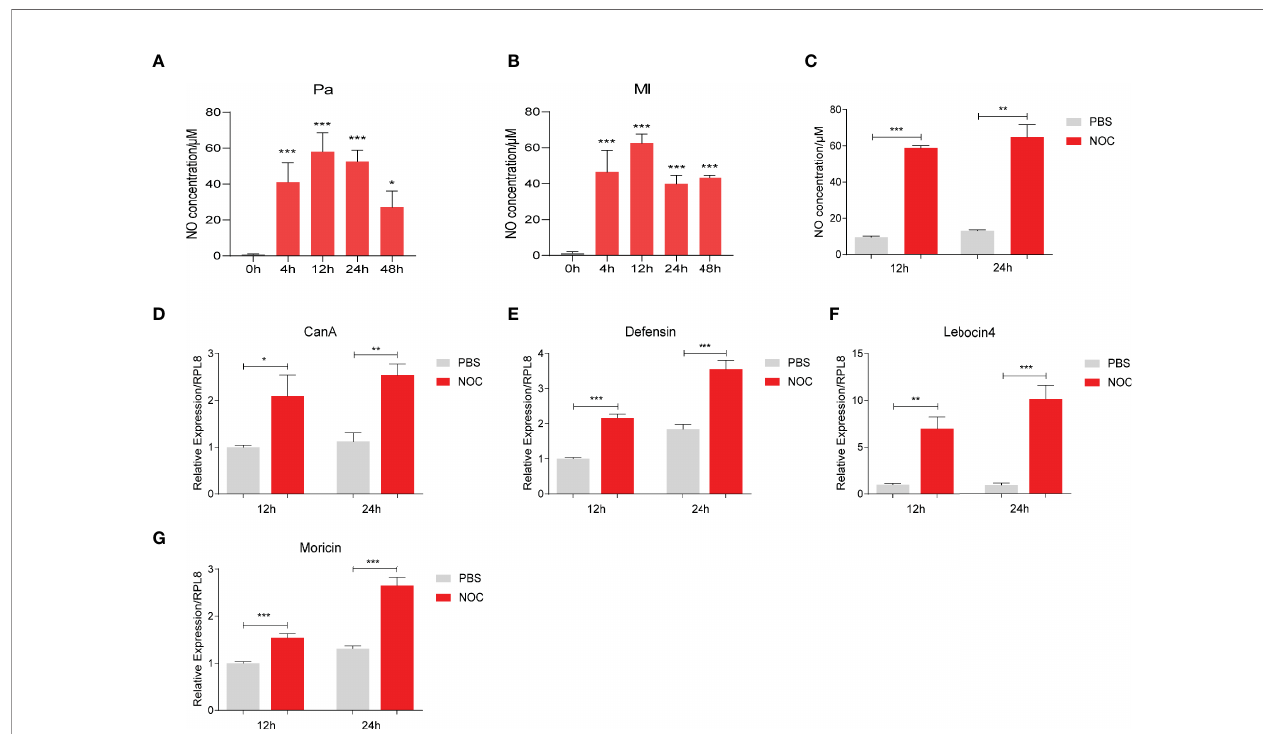
FIGURE 3 | NO increased CanA and AMP expression in O. furnacalis larvae. NO concentrations in hemolymph after infection by 1×10 4 CFUs of P. aeruginosa (A) and M. luteus (B) at 4 to 48 h post injection. NO concentrations in larval hemolymph after injection of the NOC (C) . Transcript levels of CanA (D) , Defensin (E) , Lebocin 4 (F) and Moricin (G) after NOC injection. One-way ANOVA followed by Tukey ’ s test was used to compare the control and infected groups (A, B) . Student ’ s t-test was used to compare PBS- and NOC-treated groups (C − G) . * p < 0.05; ** p < 0.01; *** p < 0.001.